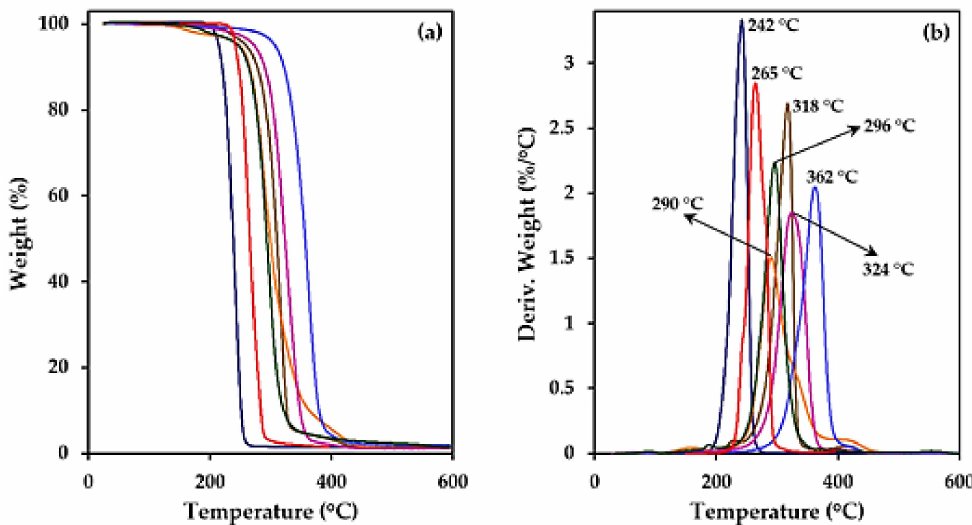
Figure 4. TGA ( a ) and DTGA ( b ) curves for the different studied terpene derivatives. Peak tempera- ture for DTGA curves increased in the order: PLC, poly(PA-LO), poly(Myr/MA-LO), poly(CPD-LO), poly(PA-MO), poly(Myr/MA-MO), poly(Myr/MA-CHO). The same colour code has been applied for TGA